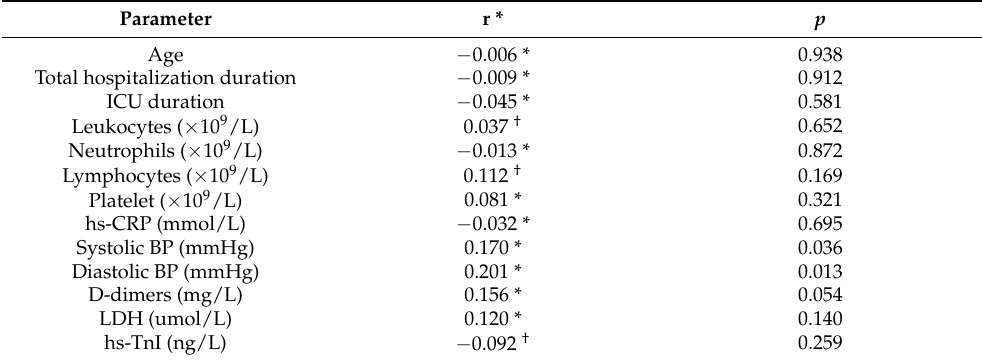
Figure 3. Catestatin correlation with ( A ) vitamin D and ( B ) GDF-15 in the whole study sample ( n = 152). * Pearson’s correlation coefficient. Table 3. Catestatin correlation with clinical and laboratory parameters.